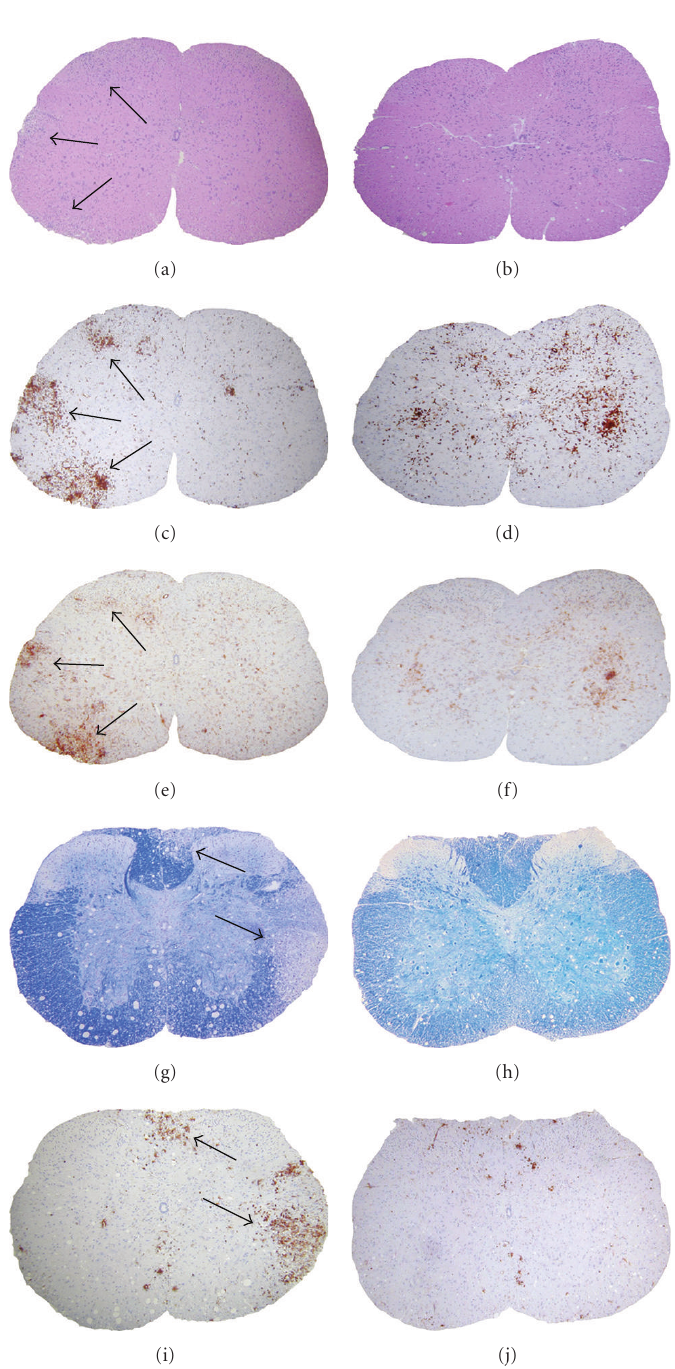
Figure 16: Distribution of inflammatory cells in the gray matter versus white matter in DM- and NDM-infected mouse spinal cord during acute infection. Serial cross sections (5 μ m thick) from DM- and NDM-infected mouse spinal cords at day 7 p.i. were stained with H & E (a, b), LCA (c, d), or CD11b (e, f). Several inflammatory lesions (a) with infiltrating LCA + cells (c) were observed in RSA59 EGFP -infected mouse spinal cord (arrows indicate lesion areas in white matter). The majority of the LCA + inflammatory cells in the inflammatory plaques were positive for the microglia/macrophage marker CD11b (e). CD11b + cells in DM-infected mice are predominantly in the white matter. In NDM-infected mice no discrete inflammatory lesions were observed (b); however LCA + cells were observed (d) scattered throughout the gray matter. These cells were also strongly immunoreactive for CD11b (f). Most of the LCA/CD11b immunoreactive cells were restricted to gray matter with very little invasion of white matter. Serial cross sections (5 μ m thick) from DM- or NDM-infected mouse spinal cords at day 30 p.i. were stained with LFB (g, h) or LCA (i, j). Large demyelinating lesions (g) with infiltrating LCA + cells (i) were observed in DM- infected mouse spinal cord white matter (arrows indicate lesion area) whereas normal myelin (h) was observed in NDM-infected mouse spinal cord with only rare scattered LCA + cells in the gray matter (j). Original magnification for (a–j) is 40x. (adapted from the work of